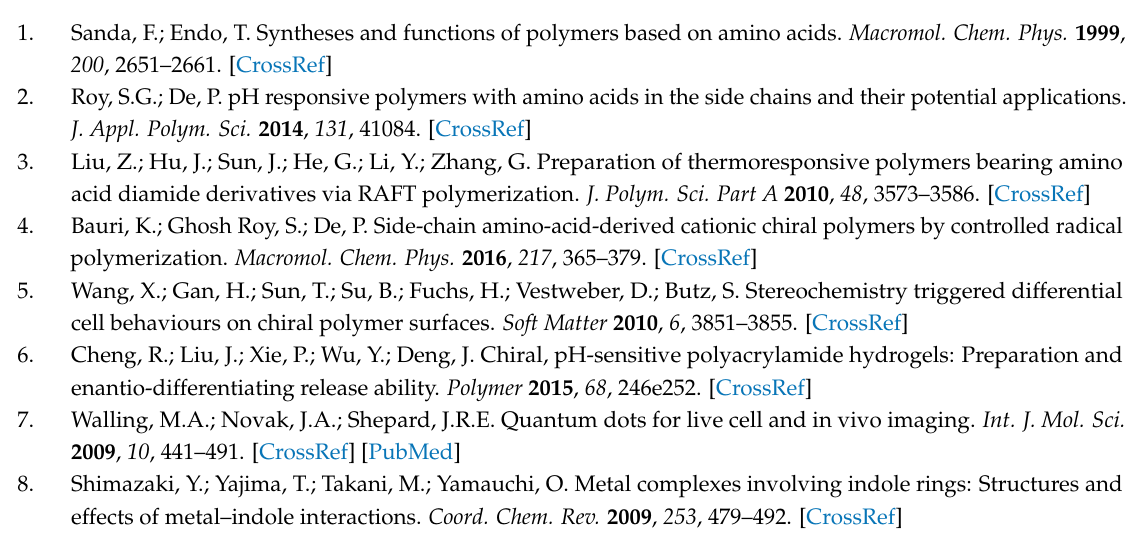
Figure S1: Titration and speciation curves referred to the 1 st experiment of Table S1 for M-G- L -Trp 5 , M-G- L -Trp 10 , M-G- L -Trp 20 and M-G- L -Trp 40 : experimental, simulated and β corrected titrations (a); distribution of charged species (b). The speciation curve of M-G- L -Trp 40 is calculated assuming pKa 1 = 2.00; Figure S2: Determination of β parameters for side –COOH and chain tert -amine of M-G- L -Trp 5 , M-G- L -Trp 10, M-G- L -Trp 20 and M-G- L -Trp 40 referred to the 1 st experiment of Table S1: calculation of β values from Eq. 1b (a); trend of the β -corrected pK a values vs α according to Eq. S1a (b); Figure S3: 1 H-NMR spectra recorded in D 2 O; Figure S4: SEC analyses (refractive index signal) of L -tryptophan-based copolymers, in 0.1 M Tris buffer (pH 8.00 ± 0.05) solution with 0.2 M sodium chloride; Figure S5: FTIR-ATR spectra of the investigated L -tryptophan-based homo- and copolymers; Figure S6: Circular dichroism and UV-vis absorption spectra of L -tryptophan-based homo- and copolymers, at pH 11; Figure S7: pH dependence of M-G- L -Trp 5 , M-G- L -Trp 20 and M-G- L -Trp 40 emission spectra recorded at λ ex = 279 nm and 25 ◦ C; Figure S8: Emission decay of L -Trp vs pH at λ ex = 301 nm: data (black line), instrument response function (IRF) (blue line) and convolution fit (red line). Weighted residuals are shown under the decay curves; Figure S9: L -Tryptophan-based homo- and copolymers spectra recorded at pH 11: a) excitation ( λ em = 356 nm) and b) UV-vis absorption. L -Tryptophan is reported for comparison purposes as well; Figure S10: pH-dependence of M-G- L -Trp 5 spectra: a) excitation ( λ em = 356 nm) and b) UV-vis absorption; Figure S11: Emission decay of M-G- L -Trp 5 vs pH at λ ex = 301 nm: data (black line), instrument response function (IRF) (blue line) and convolution fit (red line). Weighted residuals are shown under the decay curves; Figure S12: Emission decay of M-G- L -Trp 10 vs pH at λ ex = 301 nm: data (black line), instrument response function (IRF) (blue line) and convolution fit (red line). Weighted residuals are shown under the decay curves; Figure S13: Emission decay of M-G- L -Trp 20 vs pH at λ ex = 301 nm: data (black line), instrument response function (IRF) (blue line) and convolution fit (red line). Weighted residuals are shown under the decay curves; Figure S14: Emission decay of M-G- L -Trp 40 vs pH at λ ex = 301 nm: data (black line), instrument response function (IRF) (blue line) and convolution fit (red line). Weighted residuals are shown under the decay curves; Figure S15: Emission decay of M- L -Trp vs pH at λ ex = 301 nm: data (black line), instrument response function (IRF) (blue line) and convolution fit (red line). Weighted residuals are shown under the decay curves. Table S1: L -Tryptophan-based copolymers’ pK a values, calculated from forward titration data taking into accounts solubility limits. M-G- L -Trp 40 pK a values are obtained from back-titration; Table S2: Emission maximum of L -tryptophan, homo- and copolymers recorded by steady-state fluorescence measurements of non-degassed solutions in distilled water vs pH at λ ex = 279 nm; Table S3: L -tryptophan, homo- and copolymers time-resolved fluorescence measurements of non-degassed solutions in distilled water versus pH. In parentheses % of L -tryptophan populations that decay at the calculated τ time. λ ex = 301